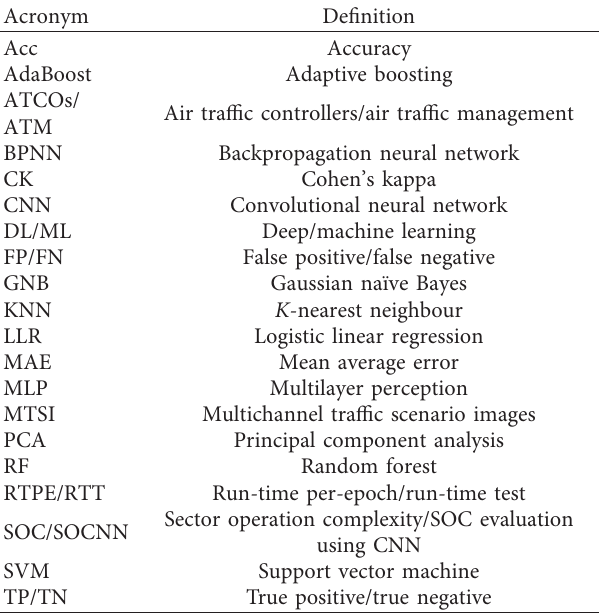
Table 1: List of the acronym used in the